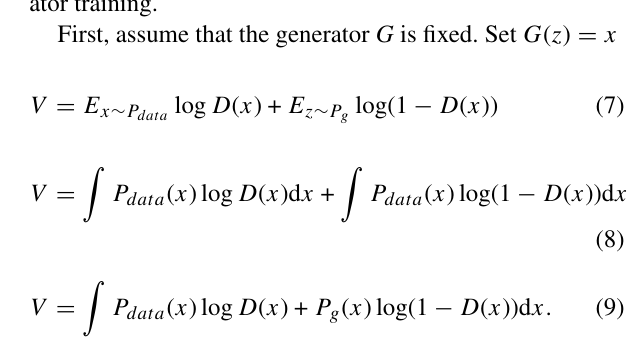
Original data x